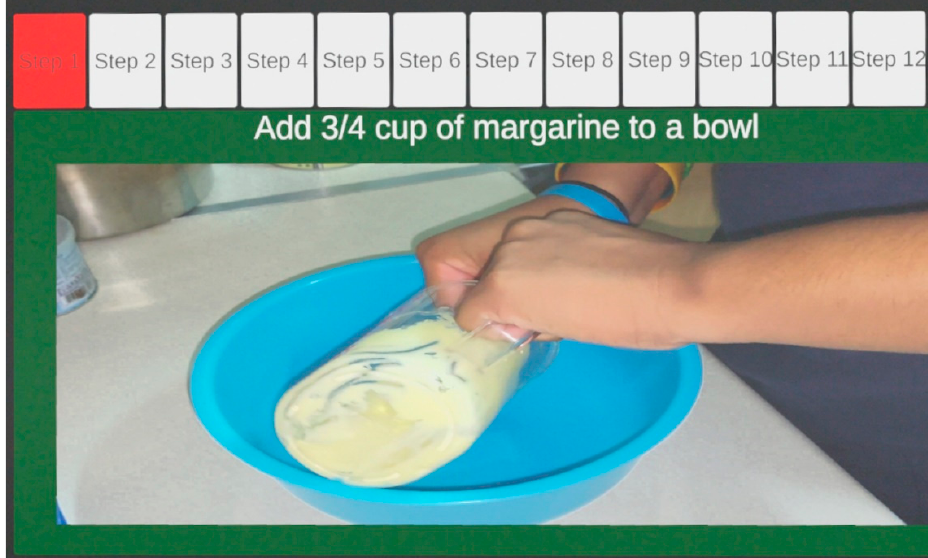
Figure 6. Step-by-step video tutorial for the recipe for white cake. The video clip is semi-transparent on the foreground so the user can see a little bit of the real scene (tiles on kitchen wall) beneath. Hands are usually busy and must remain clean in the process of cooking. Instead of